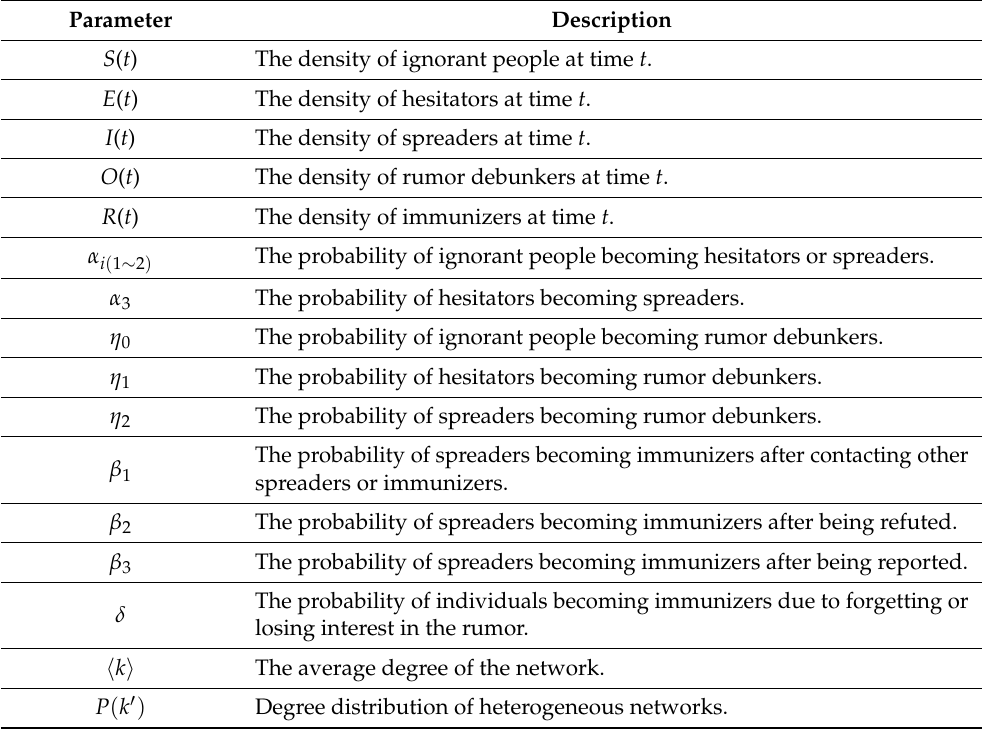
Table 1. The descriptions of the parameters in the SEIOR